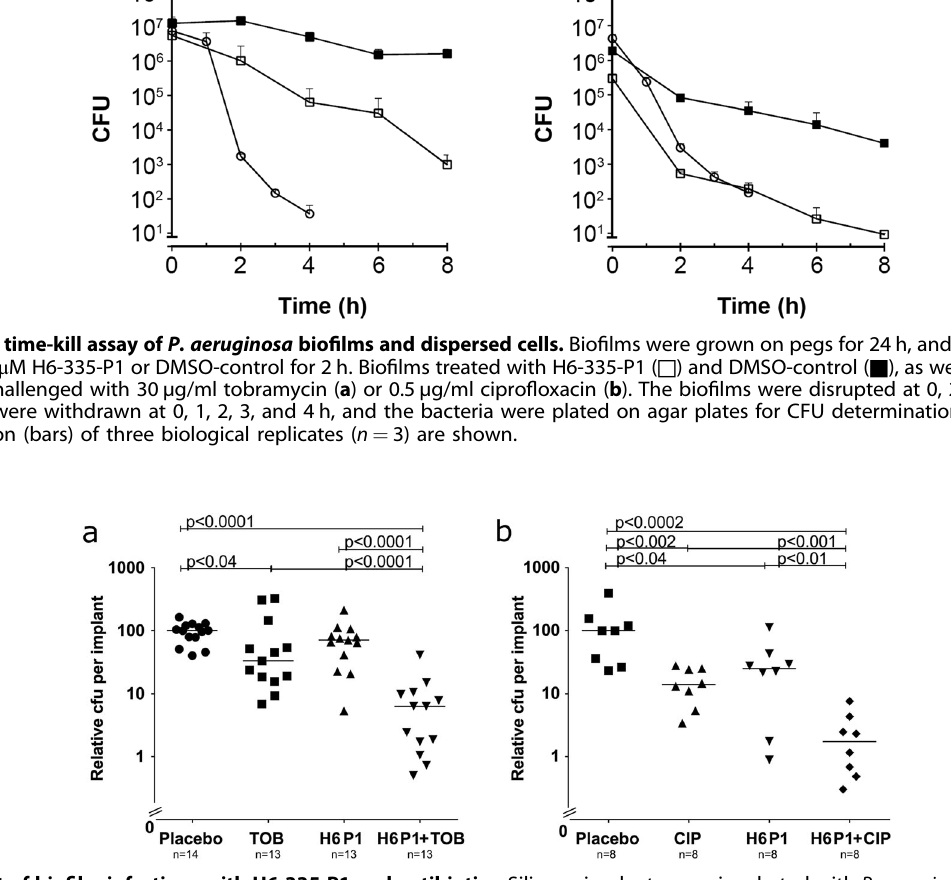
Fig. 7 Treatment of bio fi lm infections with H6-335-P1 and antibiotics. Silicone implants were incubated with P. aeruginosa cultures for 20 h for bacterial adhesion. At time zero, mice had implants inserted in the peritoneal cavity. At 24 h and 26 h post insertion of the implants (PI), the mice were treated with either H6-335-P1 (H6 P1) (25 μ M corresponding to 6 μ g compound per gram of bodyweight) or vehicle (as placebo), and at 26 h PI the mice received 30 μ g tobramycin (TOB) per gram bodyweight or 0.9% NaCl ( a ), or alternatively at 24 h PI the mice received 10 μ g cipro fl oxacin (CIP) per gram bodyweight or 0.9% NaCl ( b ). At 28 h PI, the mice were euthanized and the CFU per implant was determined. The median CFU per implant for the placebo group was set to 100. The median CFU per implant for the placebo groups were 8.5 × 10 6 ( a ) and 1.5 × 10 6 ( b ). Horizontal lines indicate median CFU for each group. Each symbol represents a mouse. Signi fi cance levels are based on Mann – Whitney U test (analysis of non-parametric